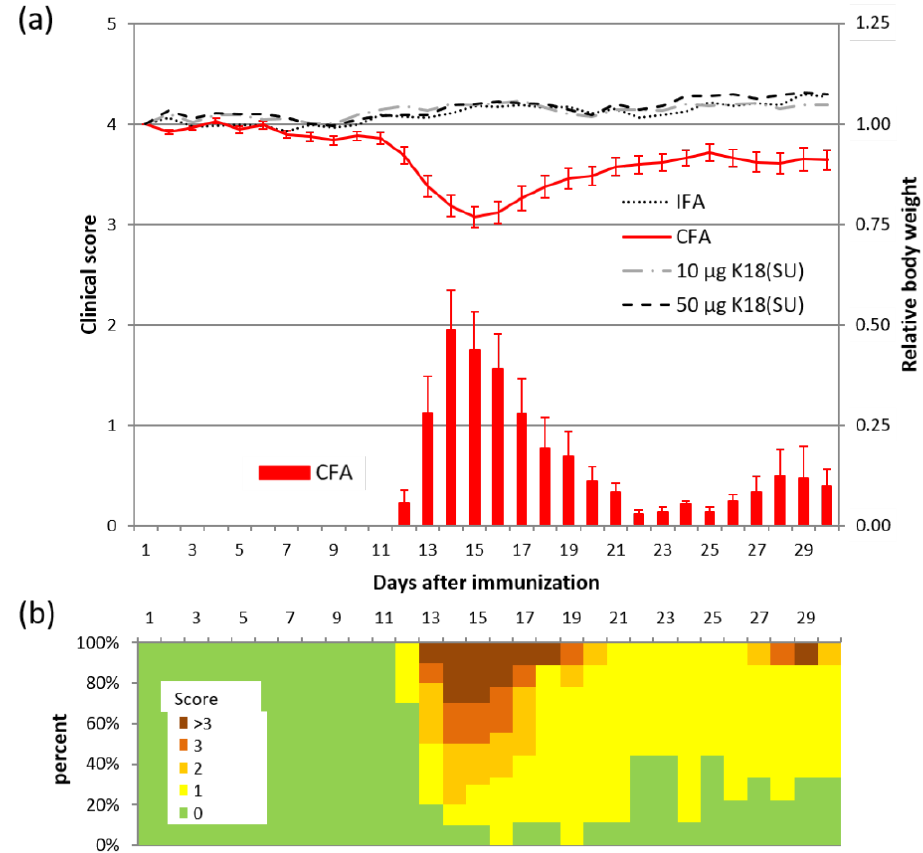
Figure 4. HERV-K18(SU) does not provoke an immune reaction in a model of EAE. ( a ) Clinical score (bar graph) and relative body weight (line graph) over 30 days for mice immunized with an emulsion containing either Freund’s complete adjuvant (CFA, n = 10), Freund’s incomplete adjuvant (IFA, n = 5), or Freund’s incomplete adjuvant and 10 µ g or 50 µ g K18(SU) ( n = 10, respectively). Data are represented as means with SE, except for the mean relative body weight of the groups receiving IFA, 10 µ g K18(SU) and 50 µ g K18(SU) for reasons of clarity. ( b ) Percentage distribution of clinical scores for CFA-immunized mice. Note that one mouse showed a biphasic disease course with a second peak at day 29.